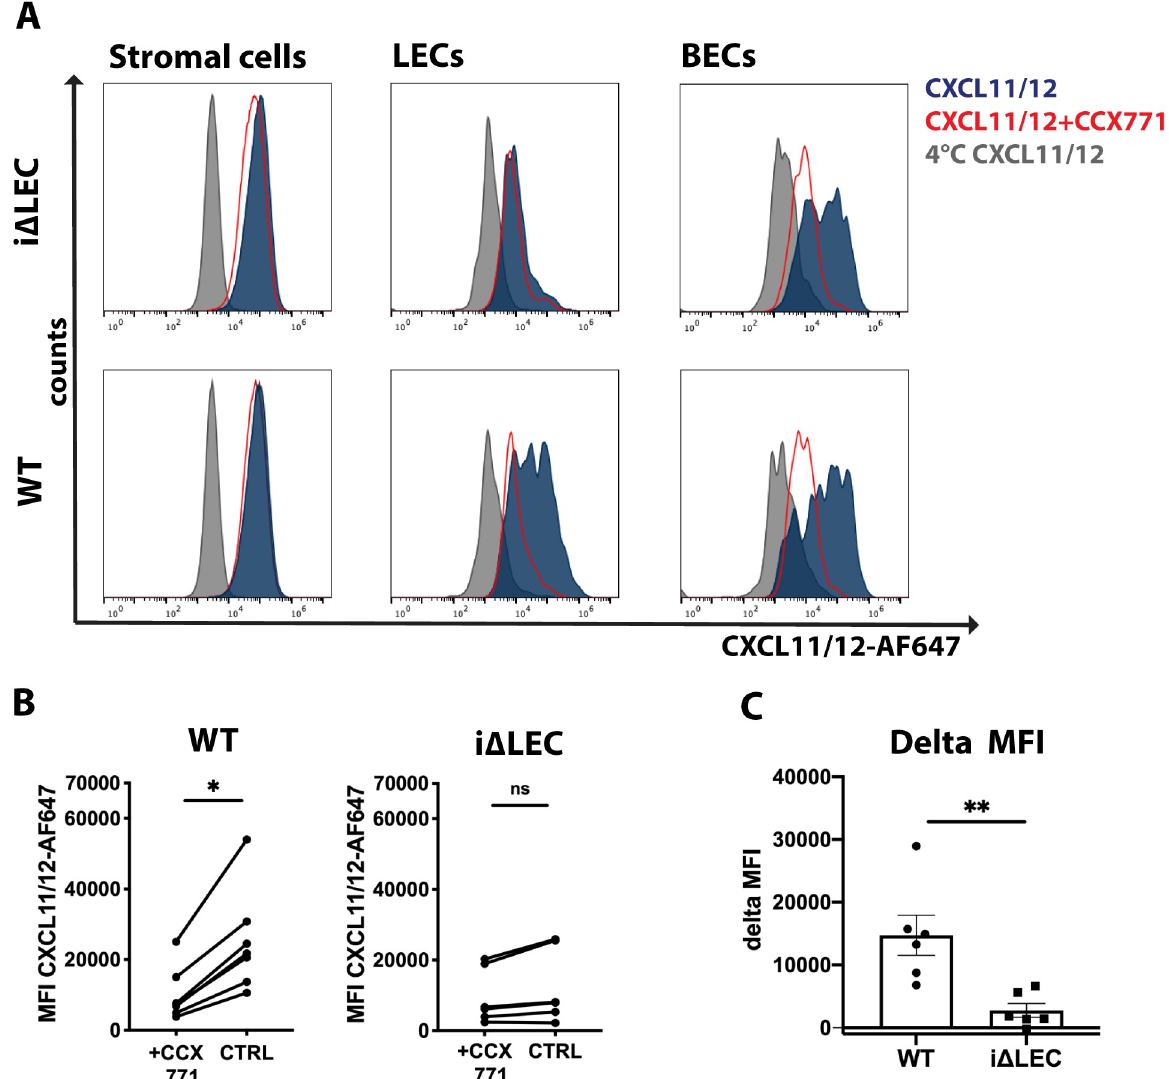
Fig 4. CXCL11/12-AF647 scavenging is abrogated in dermal LECs isolated from ACKR3 i Δ LEC animals. Dermal stromal cells were isolated from the ear skin of ACKR3 WT or ACKR3 i Δ LEC mice and their ability to scavenge the fluorescent ACKR3-specific chimeric chemokine CXCL11/12 was investigated in vitro . (A) . CXCL11/12-AF647 scavenging was specifically abrogated in dermal CD31 + Podoplanin + LECs isolated from ACKR3 i Δ LEC animals, or in LECs and CD31 + Podoplanin - BECs from ACKR3 WT mice upon treatment with the ACKR3-selective competitive agonist CCX771. Representative histograms from 1 out of 5 experiments are shown. The corresponding gating strategy is shown in S4 Fig A. 4˚C CXCL11/12: Chemokine uptake was performed at 4˚C (impaired uptake control). CXCL11/12 + CCX771: Chemokine uptake was performed in presence of CCX771. (B) Comparison of the mean fluorescence intensity (MFI) values measured in chemokine uptake assays performed in presence (+CCX771) or absence (CTRL) of CCX771 in LECs isolated from either ACKR3 WT or ACKR3 i Δ LEC mice, Wilcoxon matched-pairs test, n = 6 experiments. (C) Summary of the difference in MFI ( Δ MFI) measured in the chemokine uptake assays performed in (B) in presence/absence of CCX771 in LECs isolated from either ACKR3 WT or ACKR3 i Δ LEC mice. Mann-Whitney U-test, n = 6 experiments are shown in (B) and (C). Each dot represents the value obtained in one experiment, involving cells isolated from one